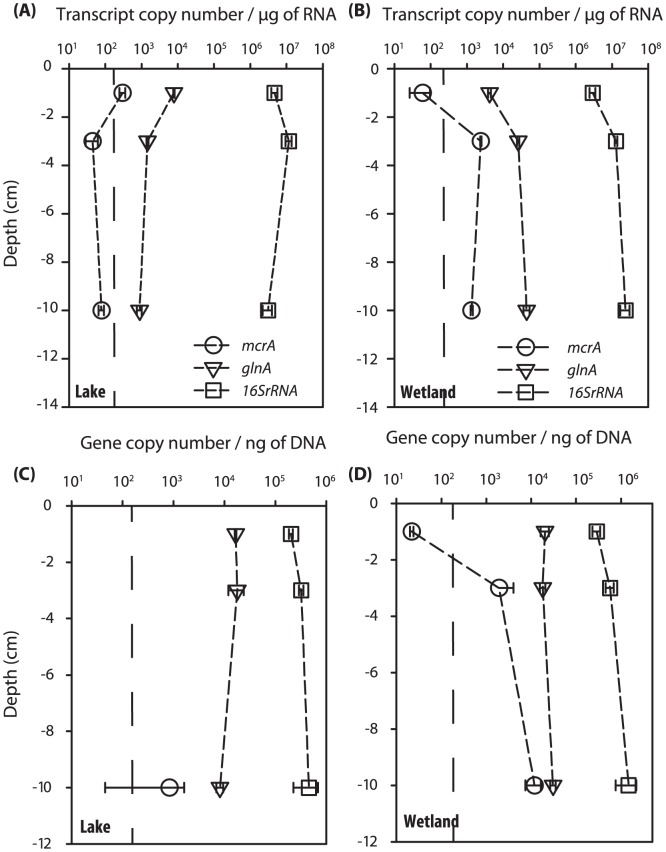
Depth profiles showing copy numbers in the pool of cDNA for mcrA, glnA and bacterial 16S rRNA in lake (A) and wetland (B) environments, and gene copy numbers for mcrA, glnA and 16S rDNA in the lake (C) and wetland (D).Vertical dashed line indicates the limit of quantification for the assay for mcrA gene transcripts. Error bars represent 1 SD.